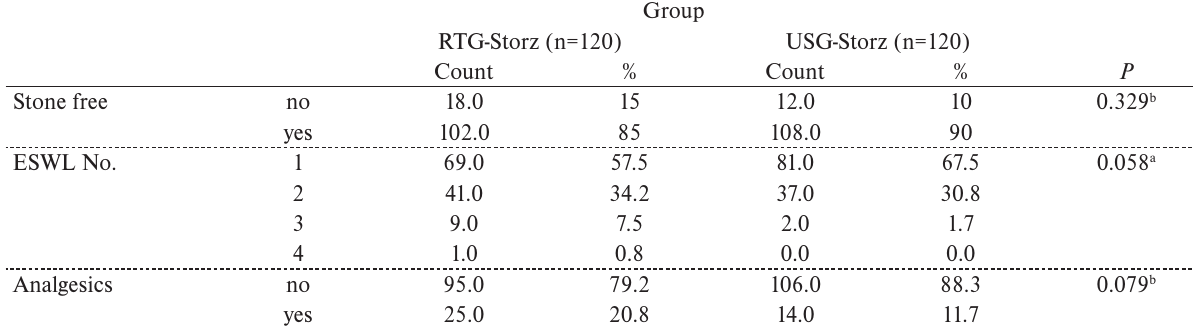
Table 2. Statistical evaluation of ESWL efficacy and rate of need for analgesics administration.